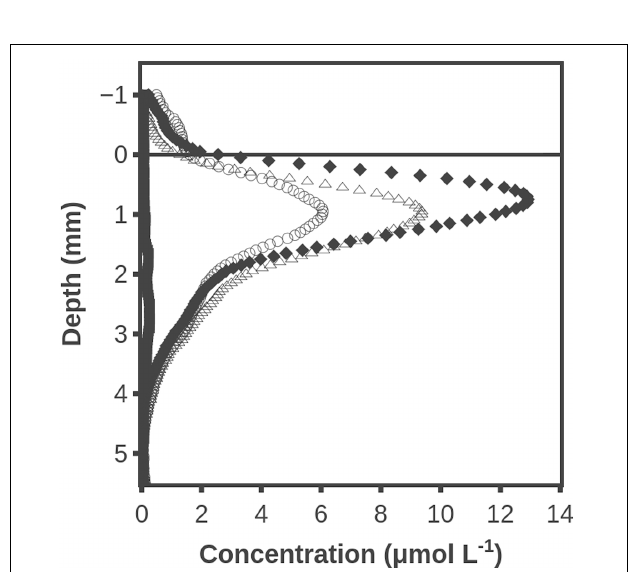
FIGURE 5 | Hydrogen accumulation after darkening when sulfate reduction was inhibited with molybdate and after 210 min where methanogenesis was additionally inhibited by addition of BES. Time after darkening: 1 min ( (cid:4) ), 120 min ( (cid:7) ), 210 min